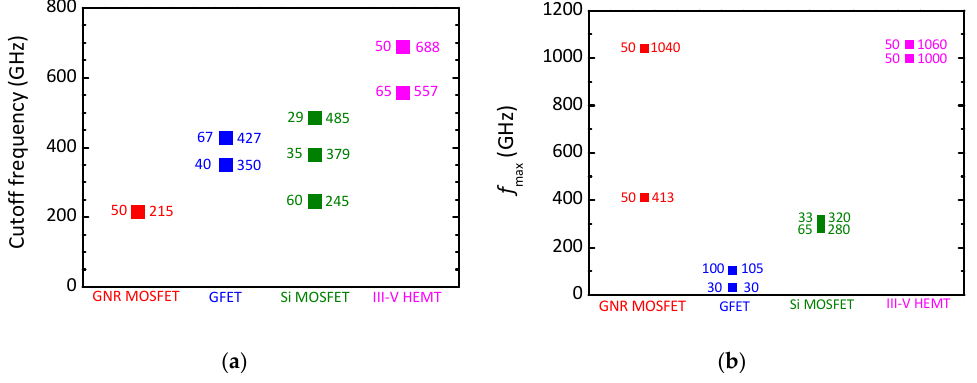
Figure 6. RF performance of the simulated 50-nm gate single-channel GNR MOSFET and of competing RF FETs (experimental data) with comparable gate length in terms of cutoff frequency f T and maximum frequency of oscillation f max : ( a ) cutoff frequency; and ( b ) maximum frequency of oscillation. The numbers at the data points indicate the gate length of the corresponding transistor in nm (at the left) and the frequency f T or f max in GHz (at the right). The data for the experimental GFETs, Si MOSFETs, and III–V HEMTs are taken from the compilations in [4–6,31,45].